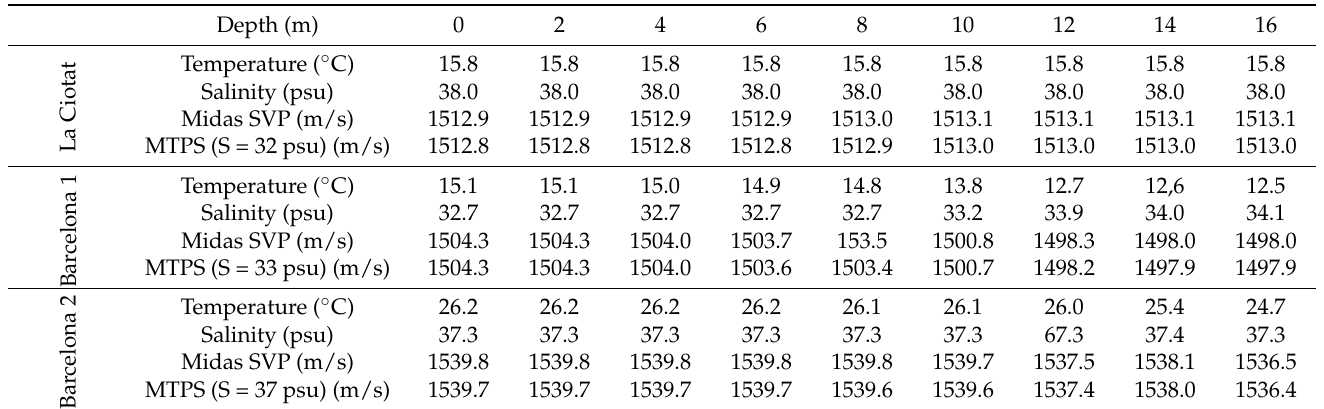
Table 11. Sound speed in water determined using selected